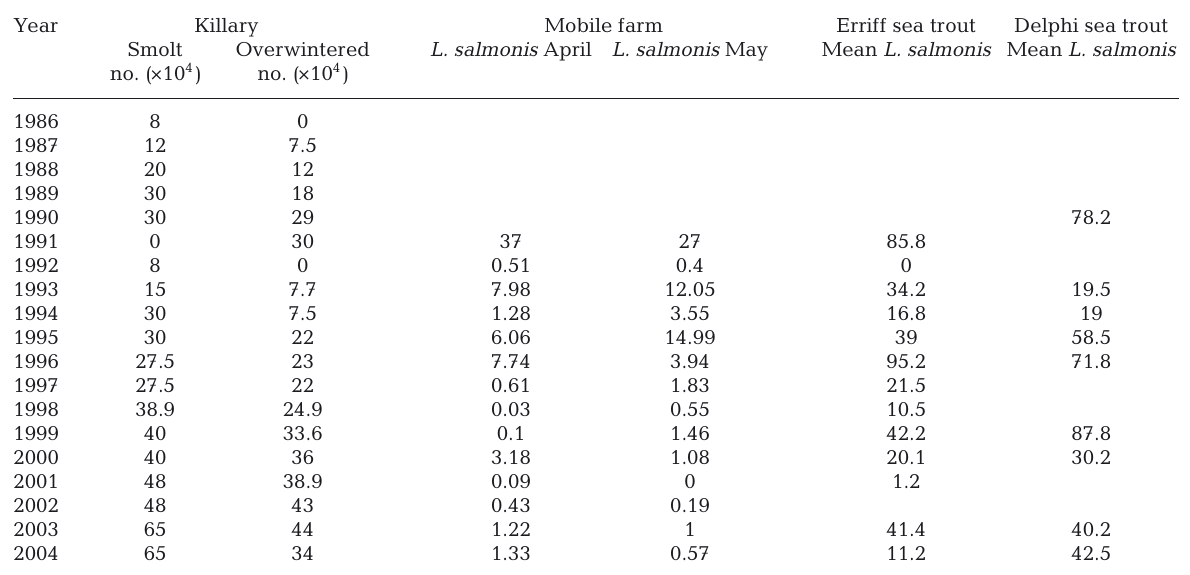
Table 1. Estimates of the Atlantic salmon Salmo salar stock at Killary salmon farm, numbers of mobile salmon lice Lepeophtheirus salmonis on farmed fish (source: Marine Institute Annual Reports) and mean L. salmonis density (no. lice fish –1